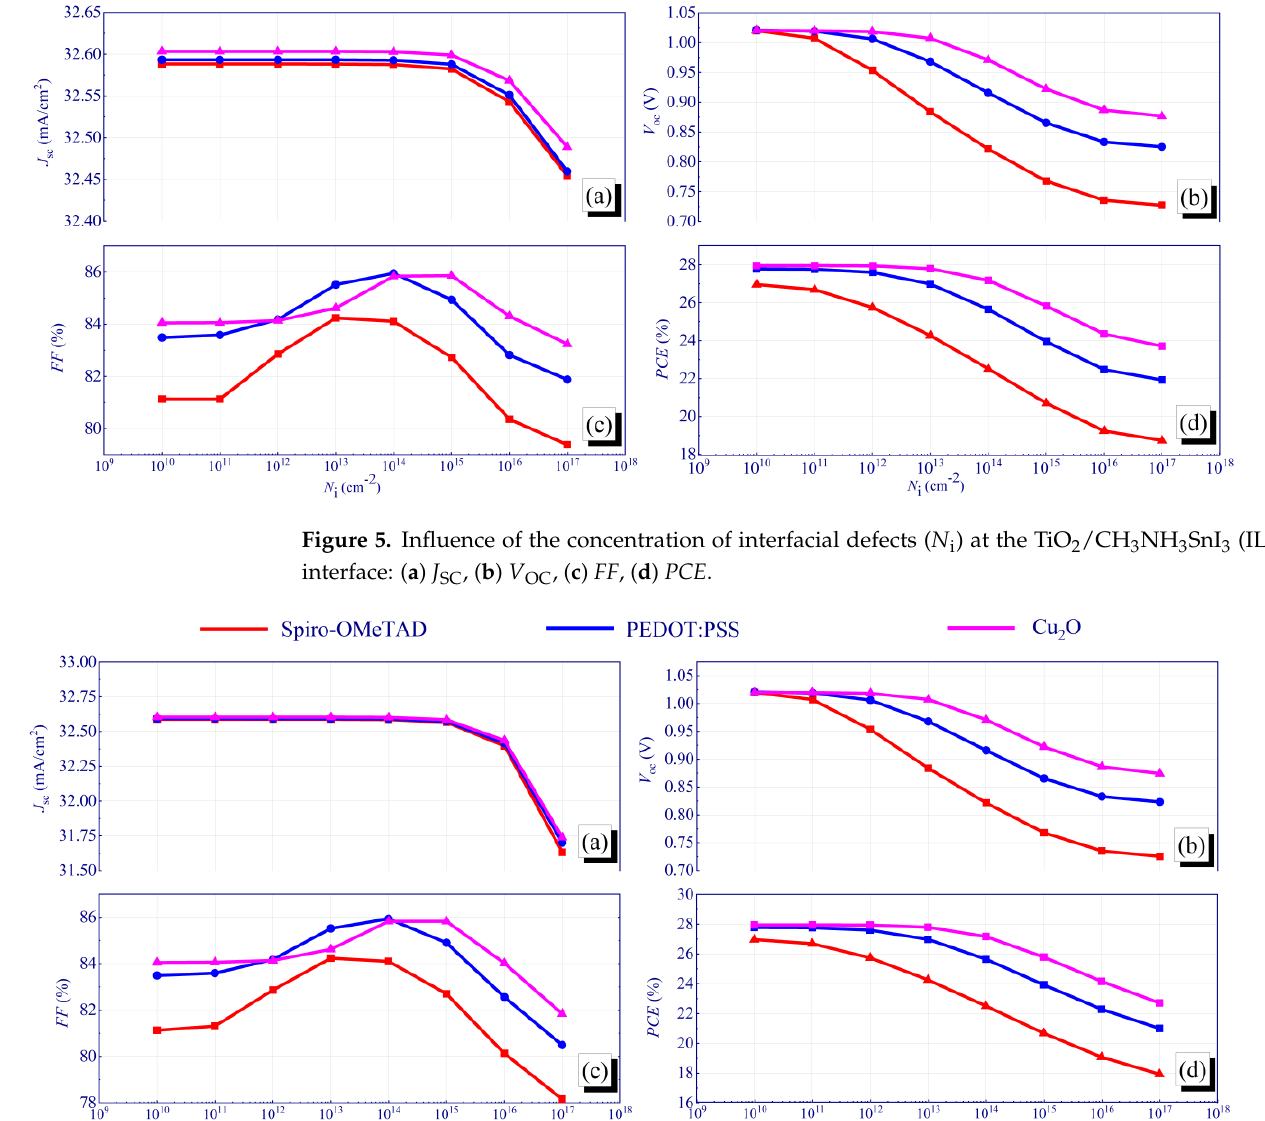
Figure 5. Influence of the concentration of interfacial defects ( N i ) at the TiO 2 / С H 3 NH 3 SnI 3 (IL1) interface: ( a ) J SC , ( b ) V OC , ( c ) FF , ( d ) PCE .